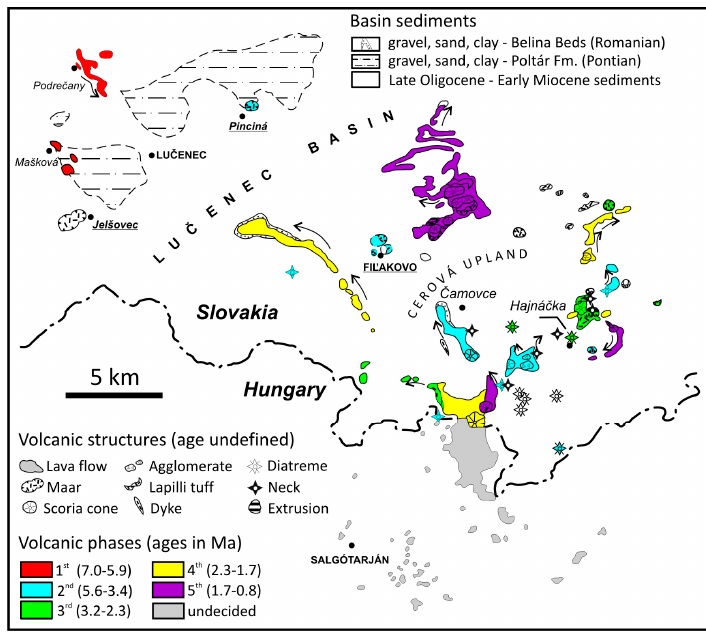
Figure 2. Enlarged view of the study area with volcanic phases inferred from geochronology